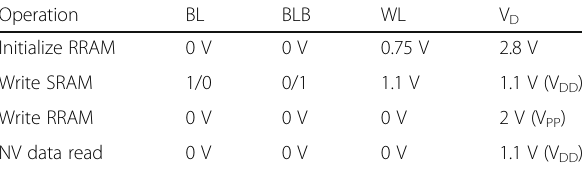
Table 1 Nv-SRAM cell operation conditions Operation